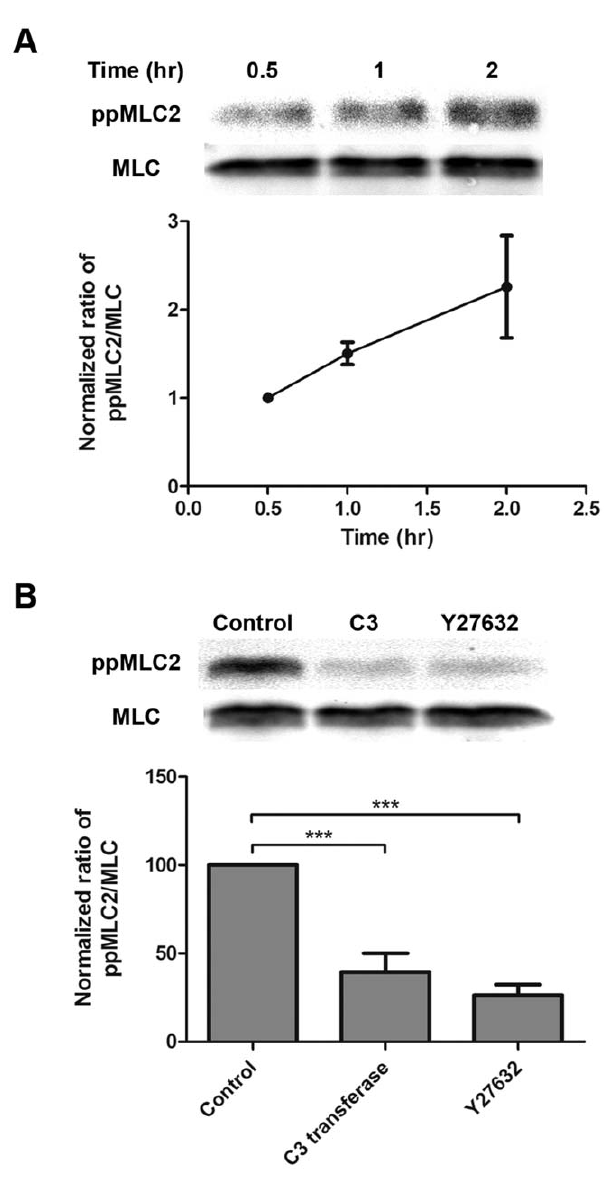
Figure 5. Galectin-8 promotes phosphorylation of myosin light chain 2 in a Rho- and ROCK- dependent manner. A: Gal8 induces phosphorylation of MLC2 in a time-dependent manner. Normal human TM cells were incubated on 100-mm dishes coated with Gal8 for 0.5, 1, and 2 hr. Following incubation, cells were lysed, and protein extracts were subjected to electrophoresis in 12% SDS-PAGE gels. Blots were probed with anti-phosphorylated myosin light chain 2 (ppMLC2) (Thr18/Ser19) antibody. The blots were subsequently stripped and reprobed with anti-MLC antibody. A representative Western blot is shown in the top panel. Images were acquired by Odyssey Infrared Imaging System, and band intensity was quantified by ImageJ (bottom panel). N=3. B: Phosphorylation of MLC2 is inhibited by Rho and ROCK inhibitors. Normal human TM cells were serum-starved overnight and treated with C3 transferase (2 m g/ml) and Y27632 (20 m M) for 4 hr. Treated cells were detached and plated on Gal8-coated dishes for 2 hr in the presence or absence of inhibitors and were then examined for the expression levels of ppMLC2 as described in the legend to panel A. Top: A representative Western blot; bottom: quantification of ppMLC2. Data are expressed as mean 6 SEM and analyzed with one-way ANOVA. *** P , 0.001 vs control.